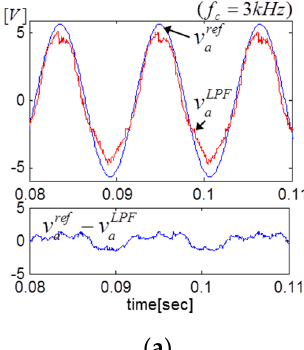
PLPF with a 0.3 kHz cut-off frequency.